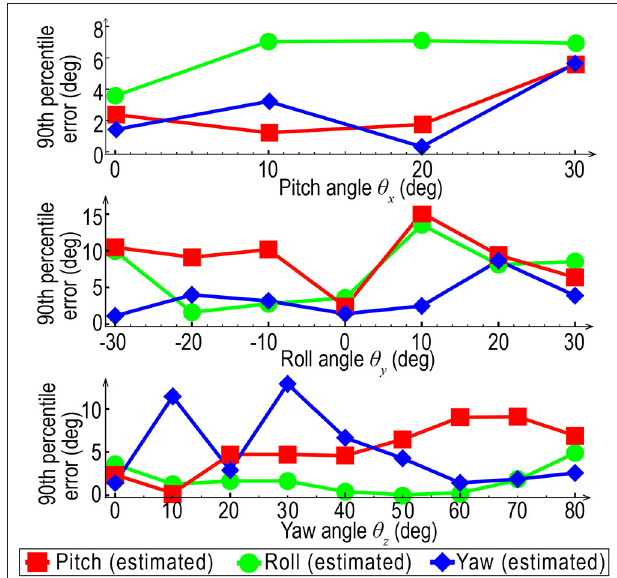
FIGURE 18 | Ninetieth percentile absolute angle error at each posture of the smartphone using nine P F i